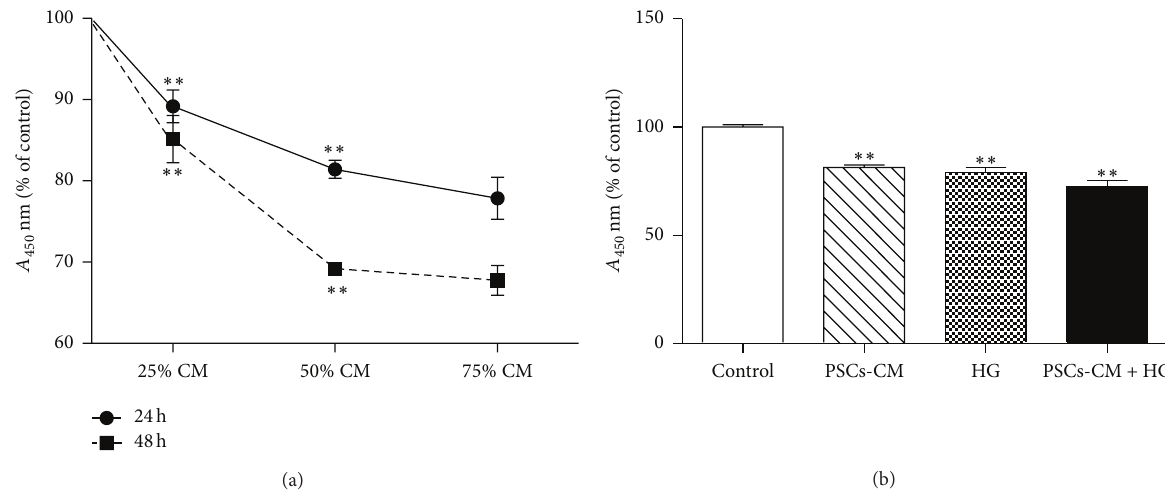
Figure 4: PSCs-CM impairs INS-1 cell viability in vitro. PSCs-CM was supplemented into the medium, forming a concentration ratio of: 0, 25, 50 and 75%. Incubation of INS-1 cells with PSCs-CM at 25, 50 and 75% (v/v) caused a significant and concentration dependent reduction in cell number compared to control INS-1 cells incubated in standard tissue culture medium. The deleterious effects of PSCs-CM were significant by 24 h, and were further enhanced after 48h treatment (a). (b) shows that the treatment with PSCs-CM or HG for 24 h were alone sufficient to reduce INS-1 cell viability, and that their effects were additive, with the combination of PSCs-CM and HG exerting a significantly more detrimental effect than either treatment alone. All data were expressed as mean ± SE ( 𝑛 = 9 ), ∗ 𝑃 < 0.05 , ∗∗ 𝑃 < 0.01 versus